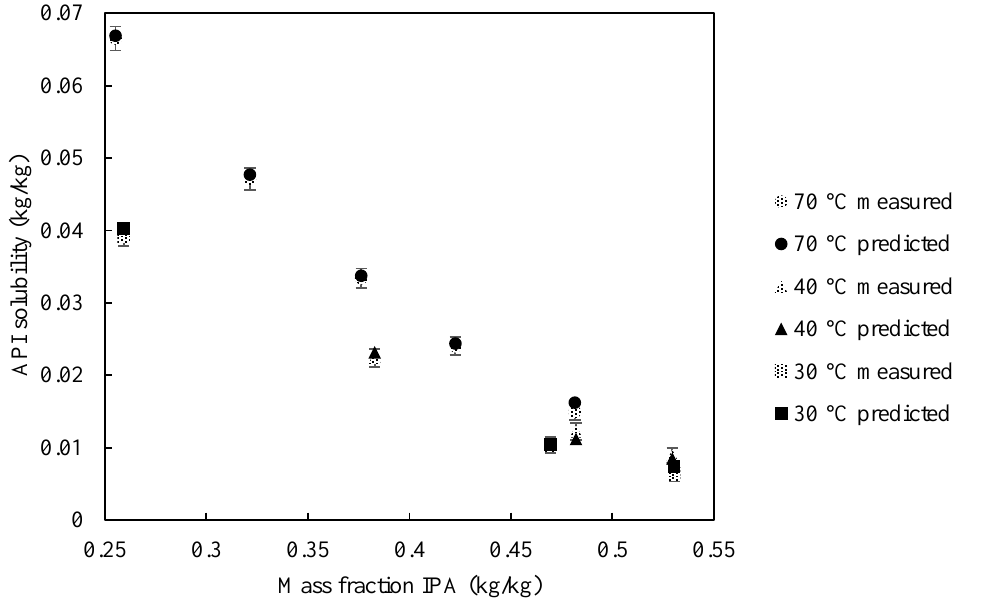
Figure 1. Comparison of measured and predicted solubility values for Bristol-Myers Squibb (BMS) Compound A across a range of antisolvent (IPA) compositions, at different temperatures.